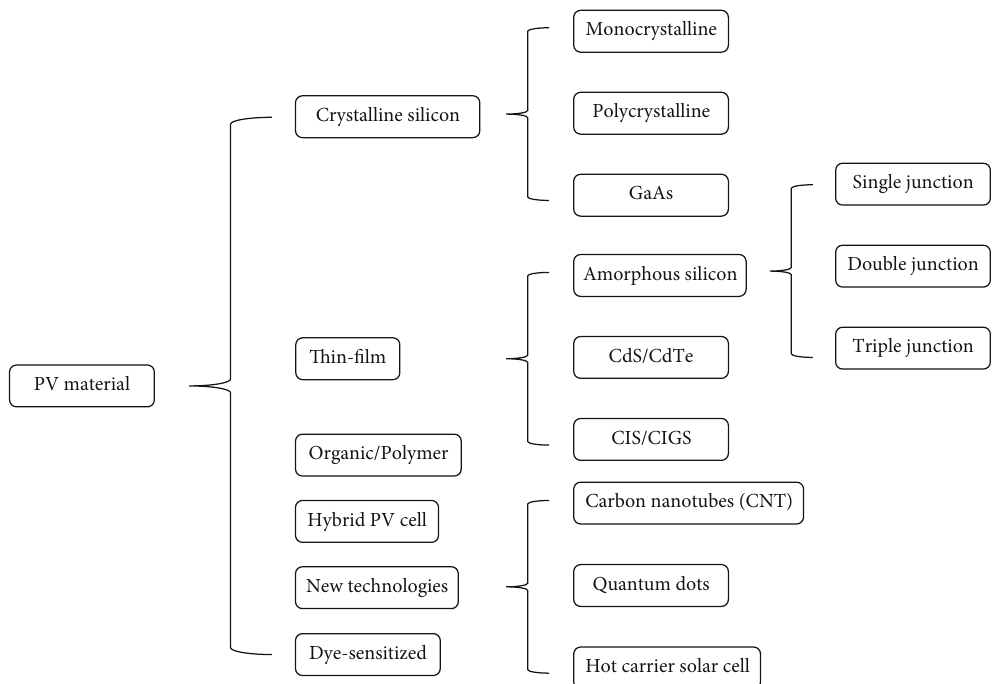
Figure 1: Di ff erent PV cell technologies